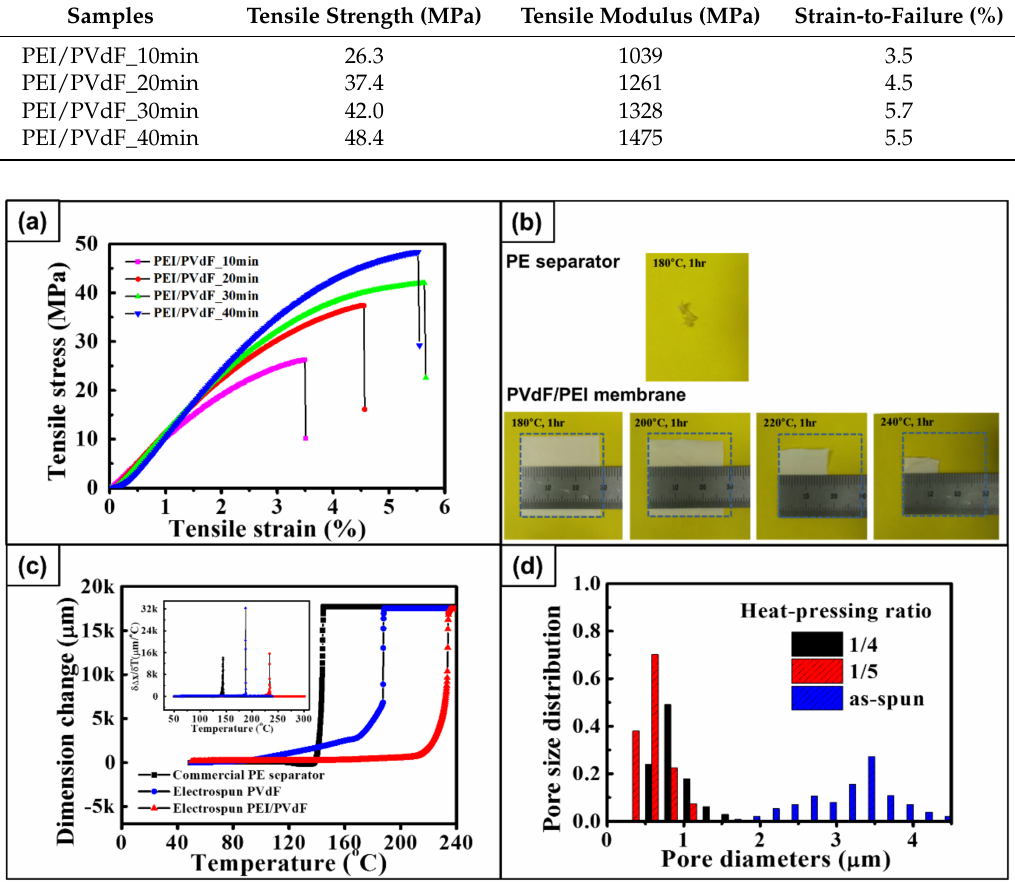
Figure 4. ( a ) Stress-strain curves of the post-treated PEI/PVdF membranes; ( b ) Photographs of commercial PE separator heat-treated at 180 ◦ C and post-treated PEI/PVdF_40min membranes heat-treated at 180, 200, 220, and 240 ◦ C; ( c ) thermo-mechanical analysis (TMA) thermograms of post-treated PEI/PVdF_40min membrane, electrospun PVdF membrane, and commercial PE separator, where the inset is the differentiated dimension; ( d ) Pore size distributions of as-electrospun and post-treated PEI/PVdF_40min